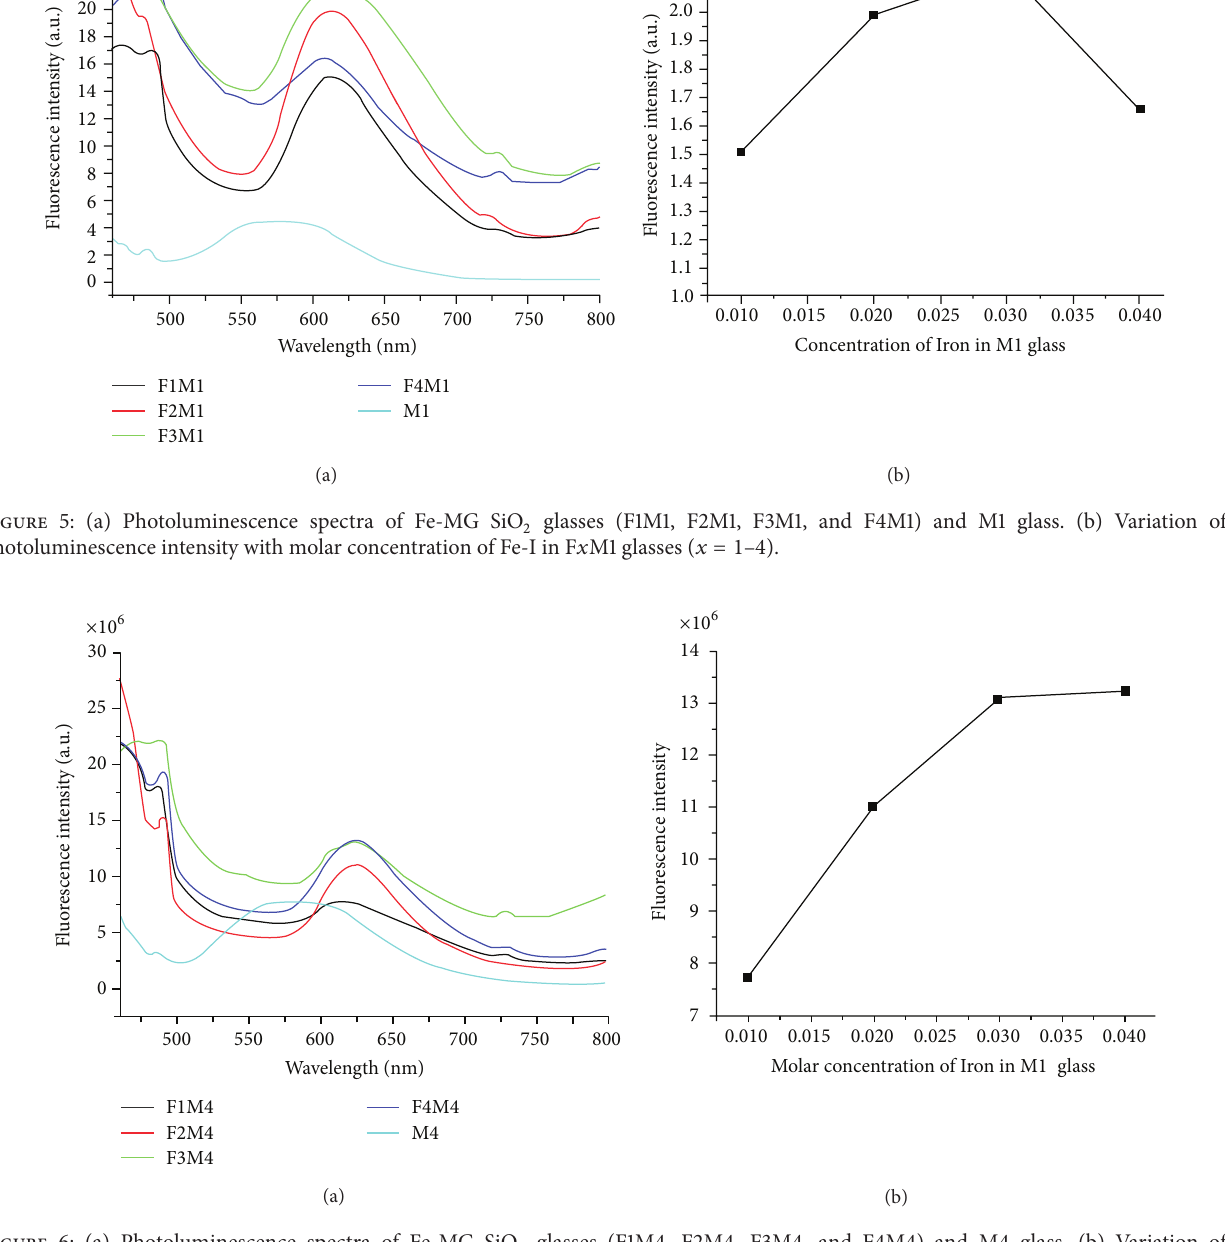
where ∫ 𝜀(𝜐)𝑑𝜐 ≈ 𝜀(𝜐) × Δ𝜐 and 𝜀(𝜐) is the molar